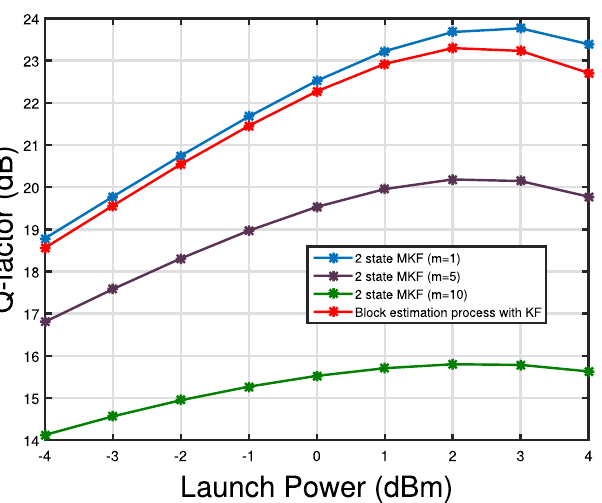
Figure 11. Q-factor versus launch power curve for 2 state MKF for CFO = 100 MHz and 3 spans. For 2 state 100 kHz, For block estimation of KF �ν MKF �ν =